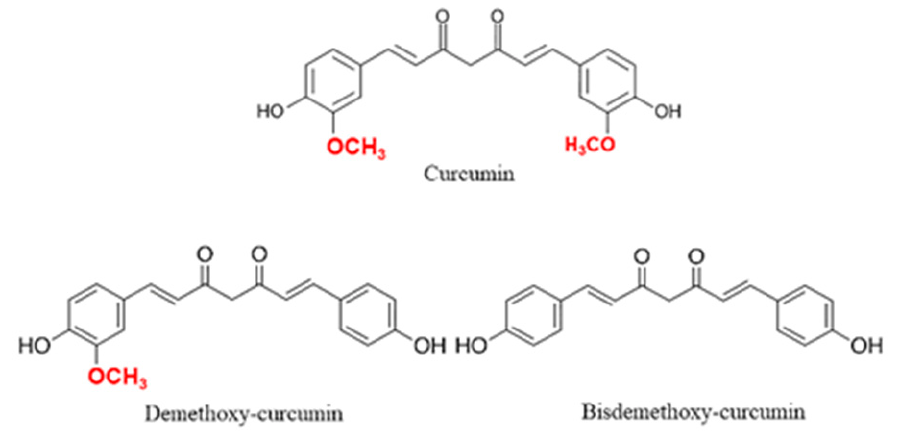
Figure 1. Curcuminoids chemical